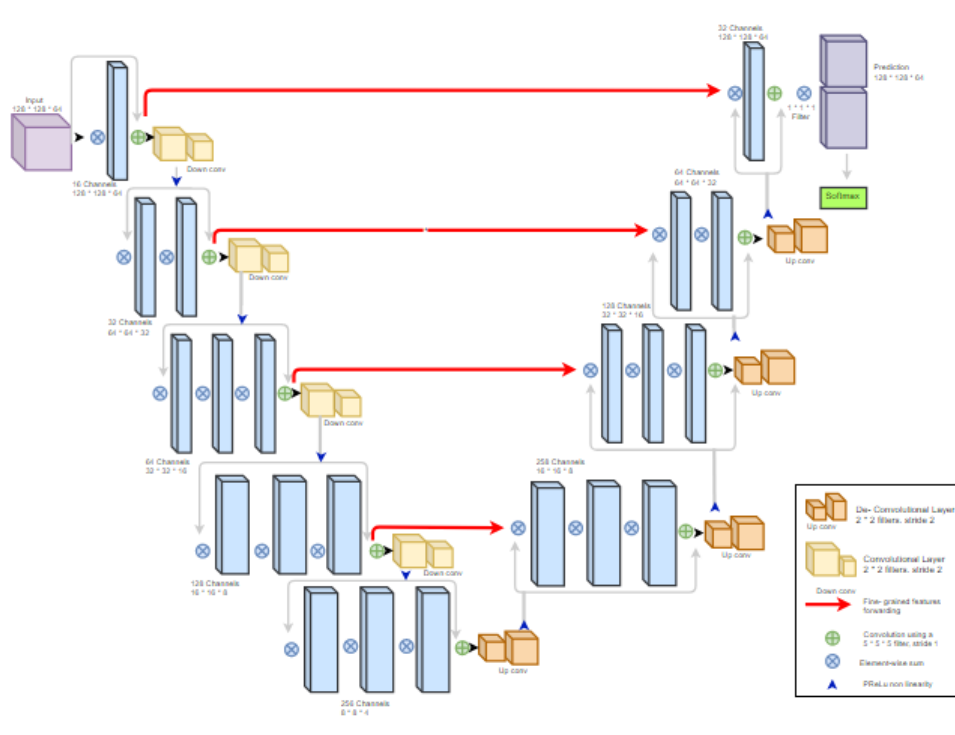
Figure 14. V-Net architecture.